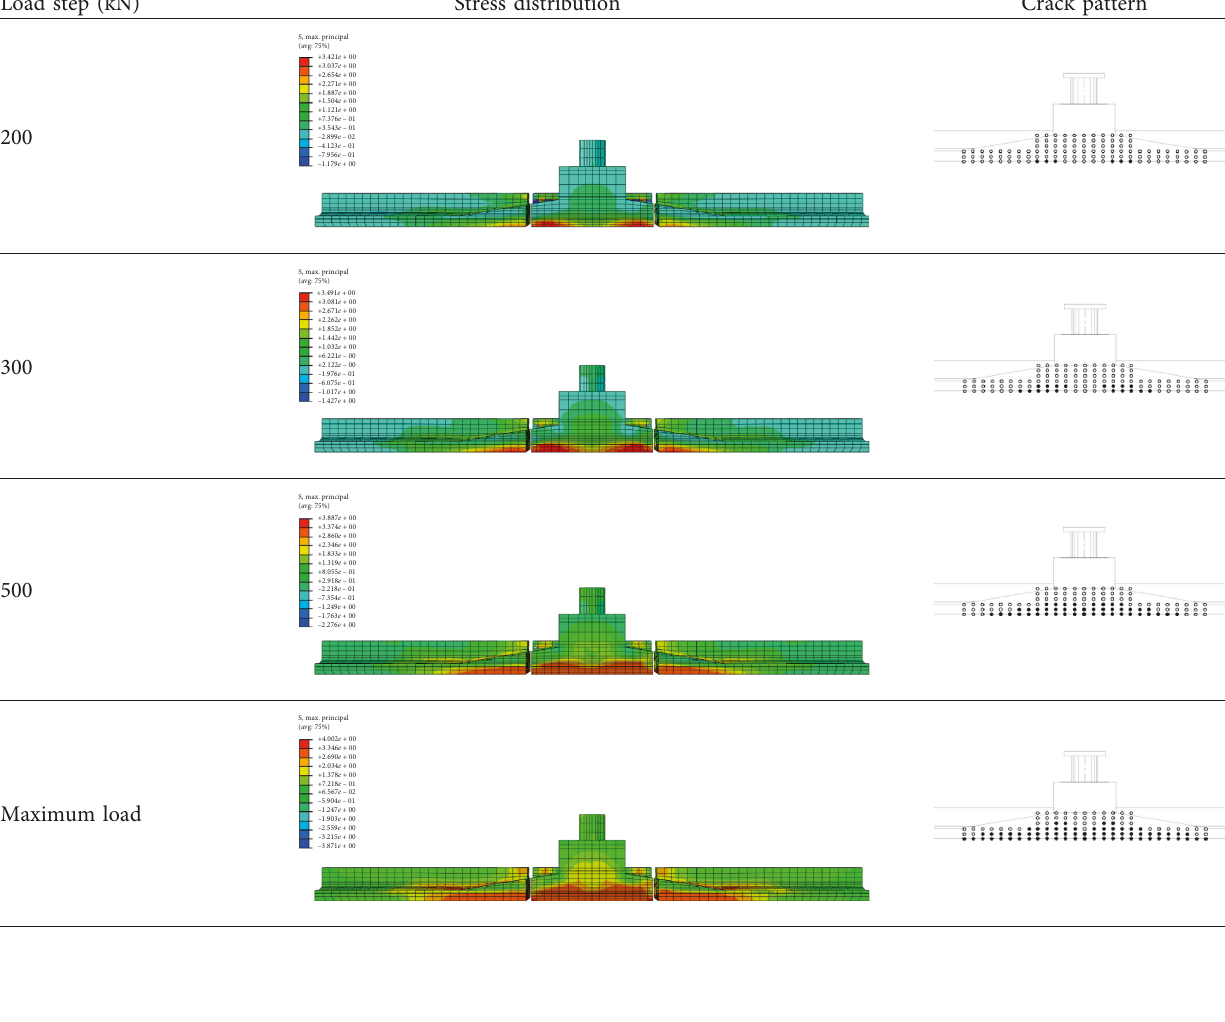
Table 3: Stress distribution and crack pattern from FE model.